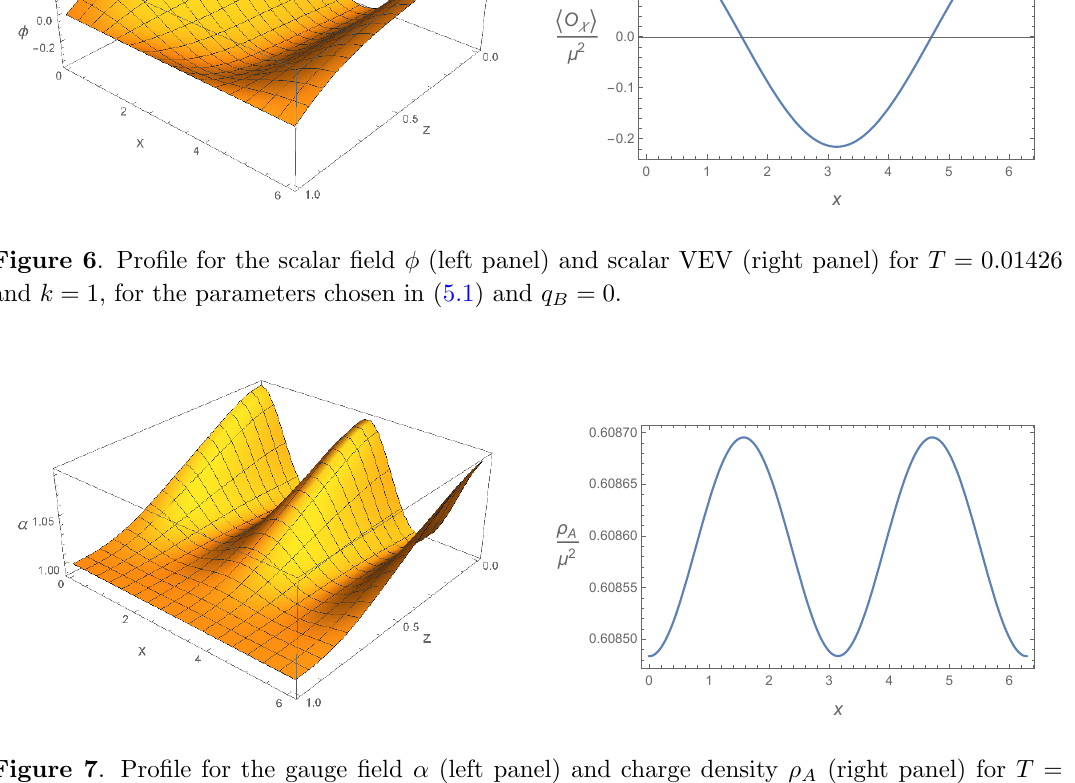
Figure 7 . Pro(cid:12)le for the gauge (cid:12)eld (cid:11) (left panel) and charge density (cid:26) A (right panel) for T = 0 : 01426 and k = 1, for the parameters chosen in (5.1) and q B = 0.